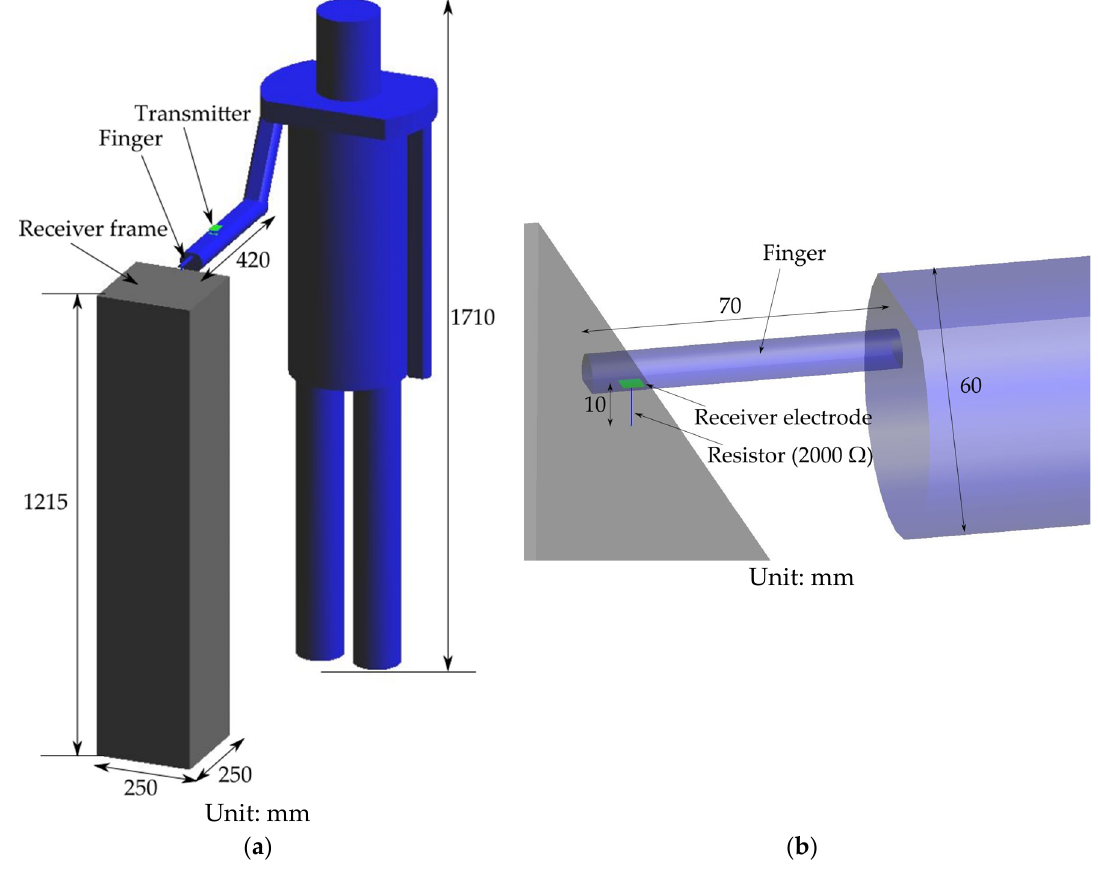
Figure 1. Numerical simulation model. ( a ) Full model. ( b ) Detailed view of the finger touching the receiver electrode.